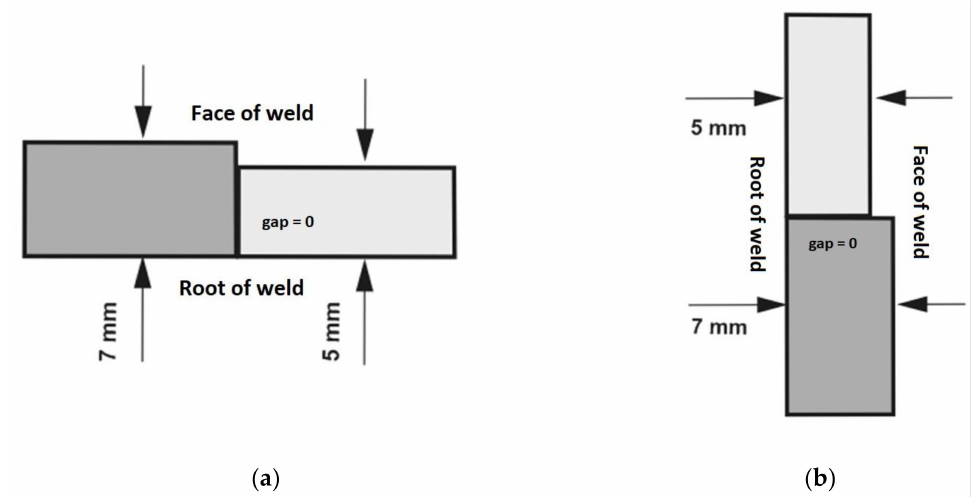
Figure 4. Setting up and plate thicknesses used in the tests: ( a ) flat position (PA) and ( b ) horizontal position (PC) (according to ISO standard